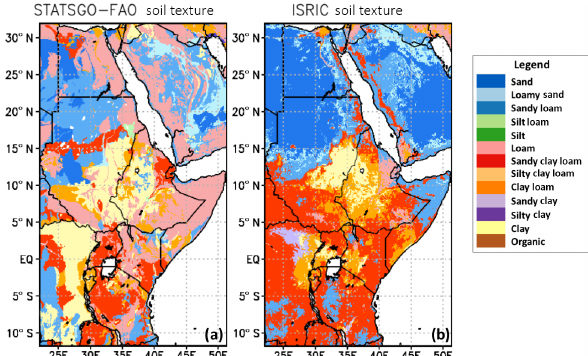
Figure 5. Comparison of the (a) STATSGO-FAO soil texture class map (originally at 1km resolution) versus the (b) ISRIC soil texture map (originally at 250m resolution). Dominant texture classes are shown here at 10km spatial